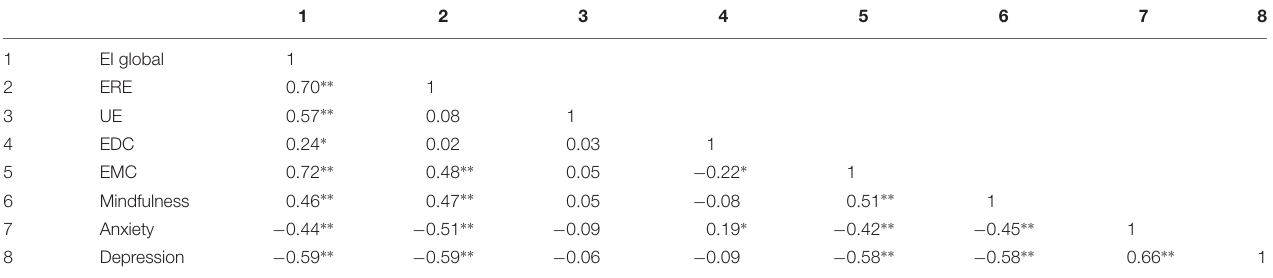
TABLE 2 | Pearson correlations between